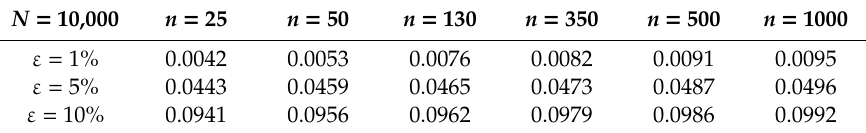
Table 2. Simulated levels of significance for Y 2 n